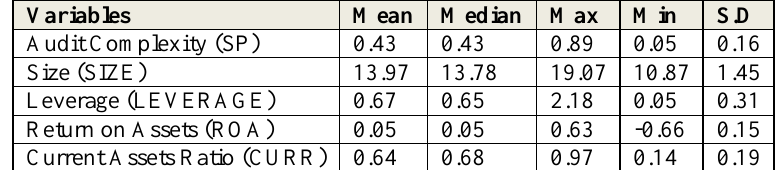
Table 1 . Descriptive Statistics of Research Variables